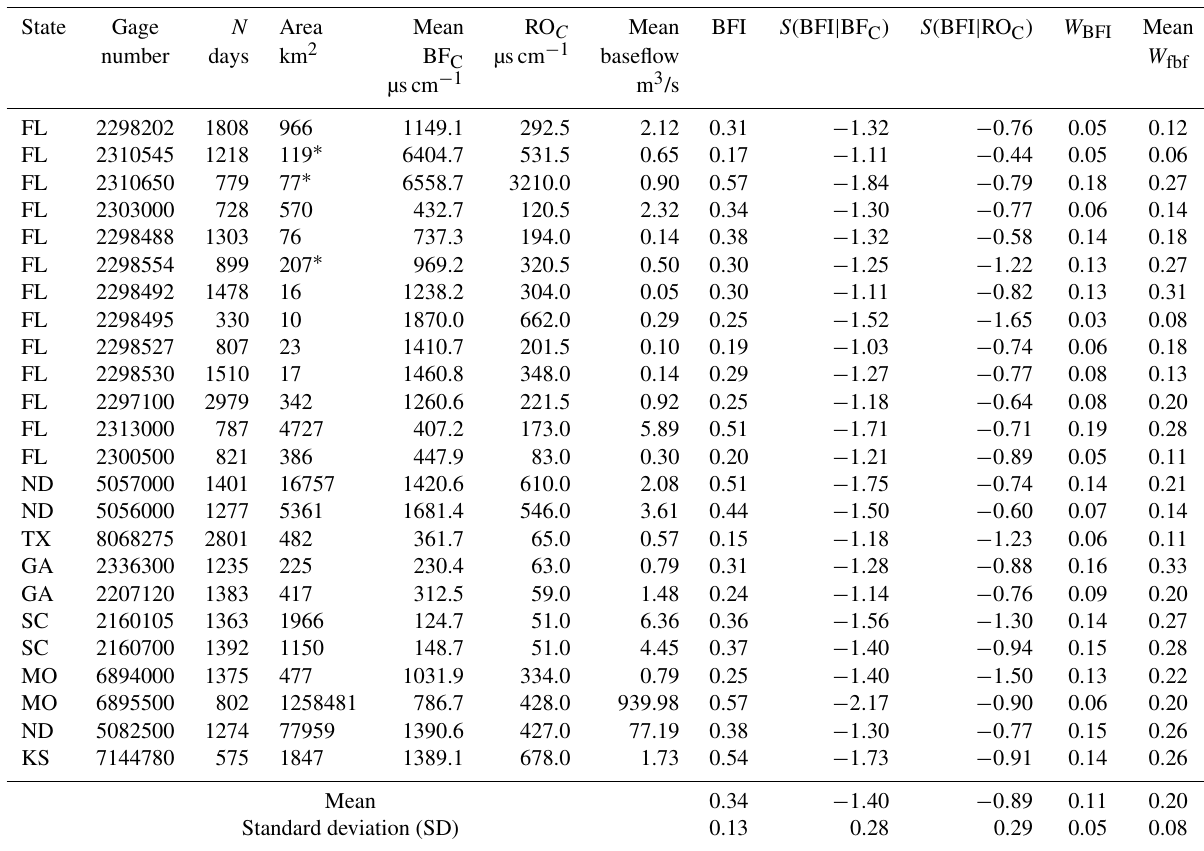
Table 1. Basic information, parameter sensitivity analysis, and uncertainty estimation results for 24 basins in the US. The asterisk in the “area” column indicates that the values are estimated based on data from adjacent